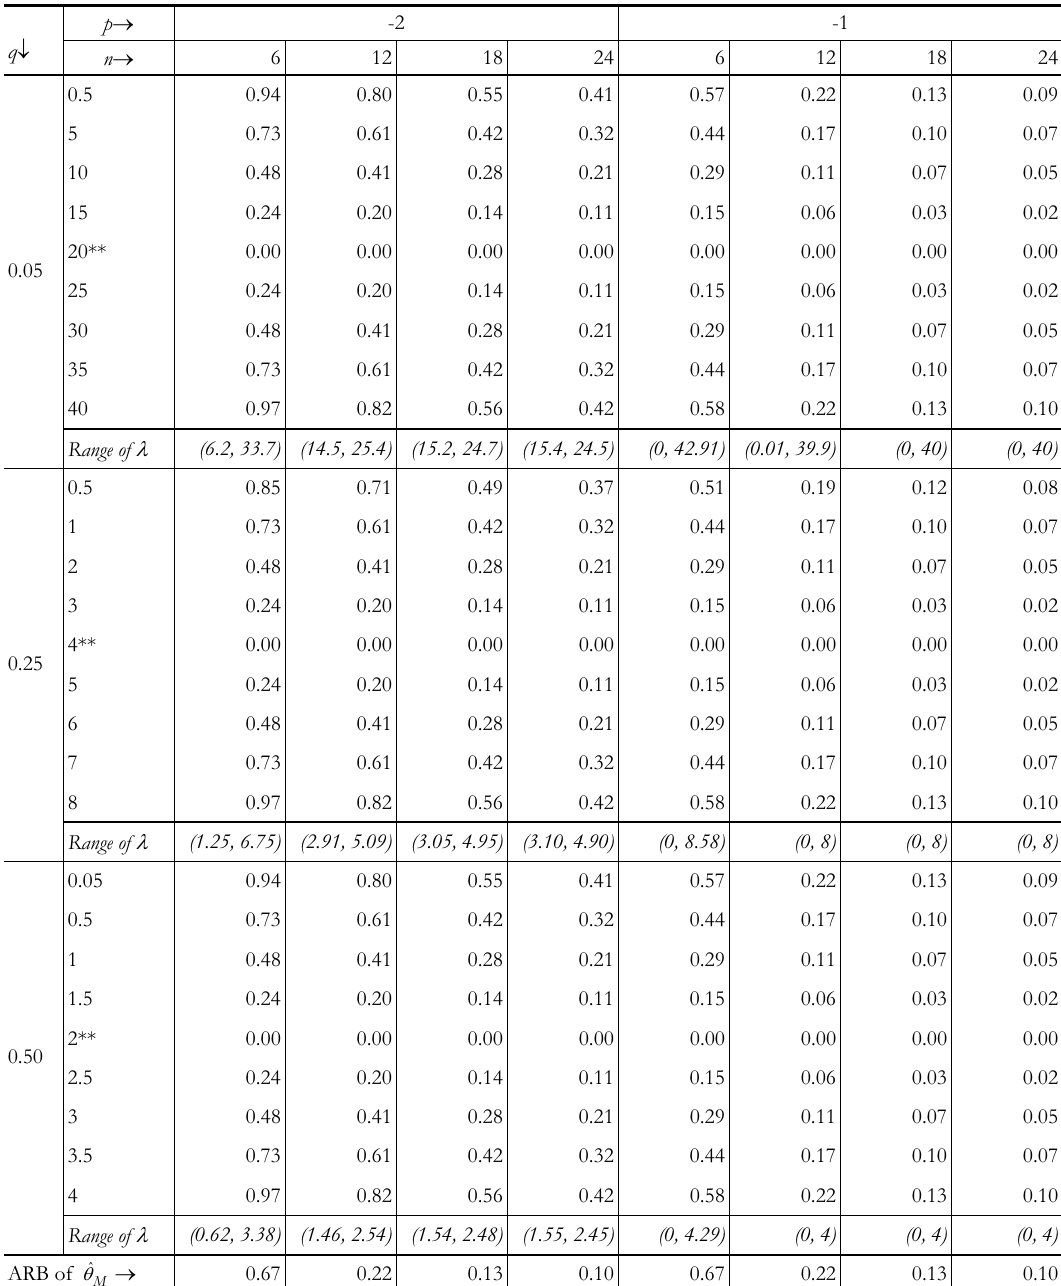
ˆ (cid:84) and MMSE estimator ˆ p q ( , )